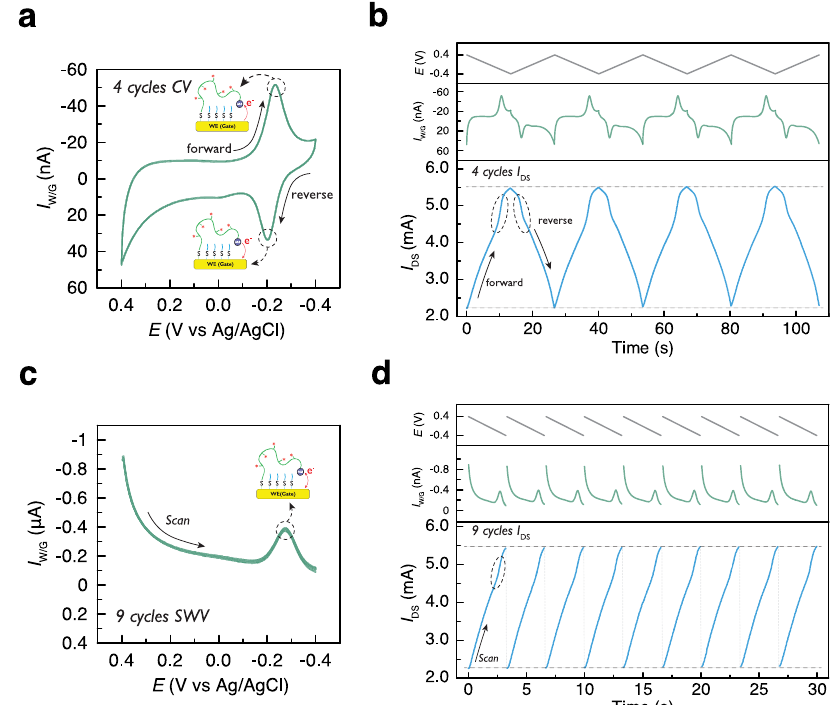
Fig. 2 | Continuously operation of ref-OECT-based E-AB sensor. a 4 scans of cyclicvoltammetry(CV)oftheE-ABsensorwithscanrate60mV/sandstepvoltage 0.004V. b Real-timevoltageonworkingelectrode,workingelectrodecurrent/gate currentandchannelcurrentoftheOECTwhenperformingCVmeasurementinthe E-ABsensor.Stable I DS modulation( V DS = − 0.2V)isdemonstratedduring4CVscans and the sudden changeof I DS indicated by the circles owing to the high reduction/ oxidation gate current from the MB redox reporter. c 9 scans of square-wave